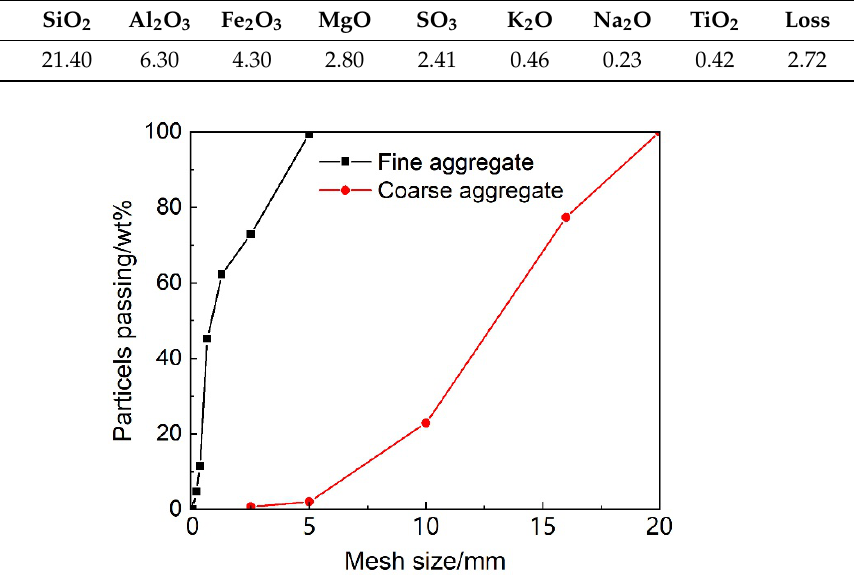
Figure 1. The particle size distribution curves of the aggregates.